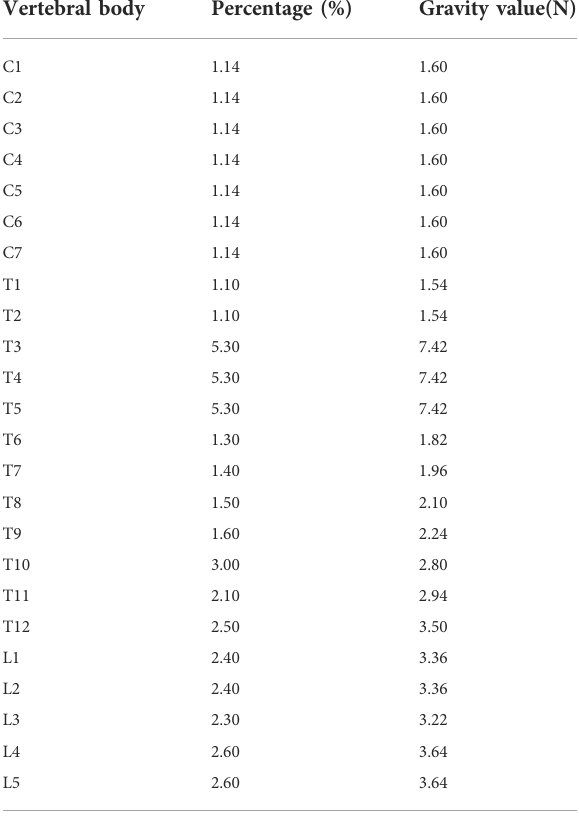
TABLE 2 Gravity value and percentage of body weight borne by the vertebral